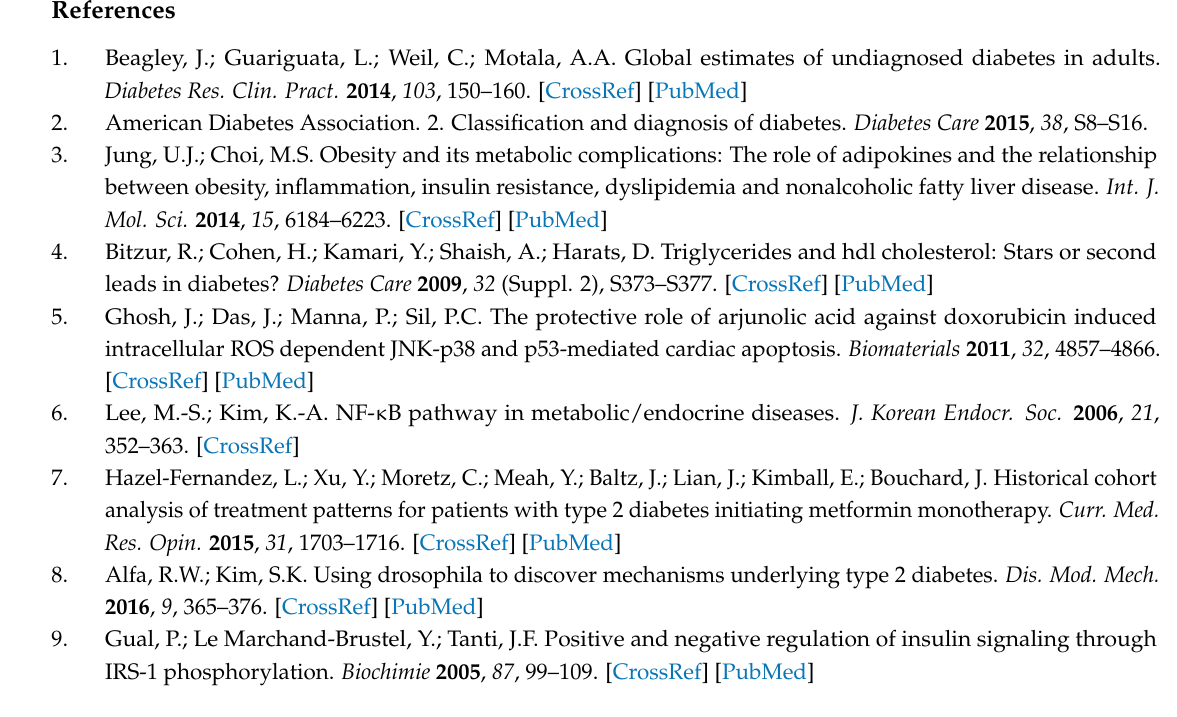
Table S1: Histopathological examination results of diabetic rats.